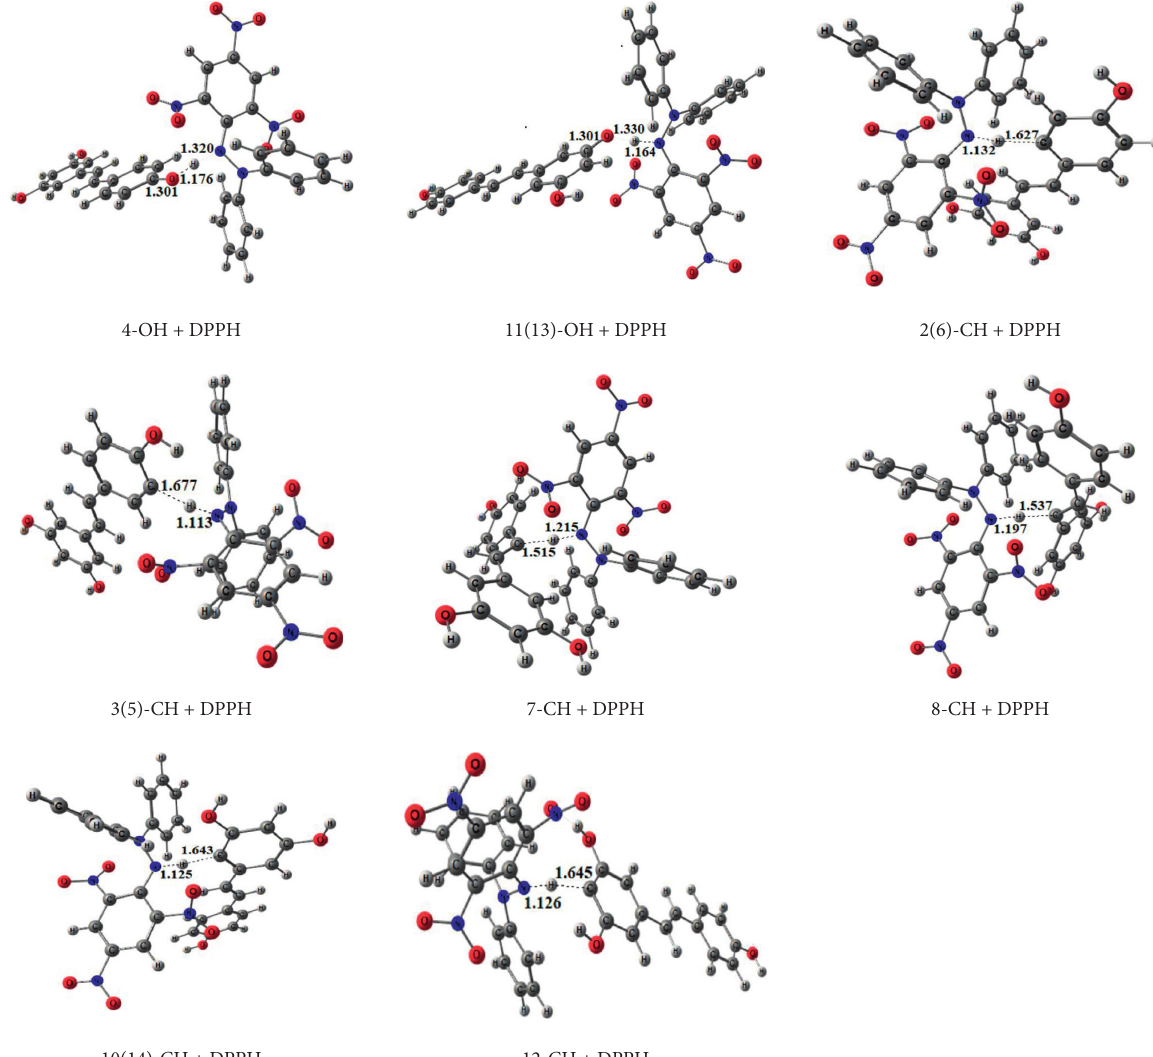
Figure 6: The optimized structures of transition states (TSs) when DPPH radicals attacked hydroxy and methine groups of RSV at B3LYP/6- 311++G(d, p) level of theory.